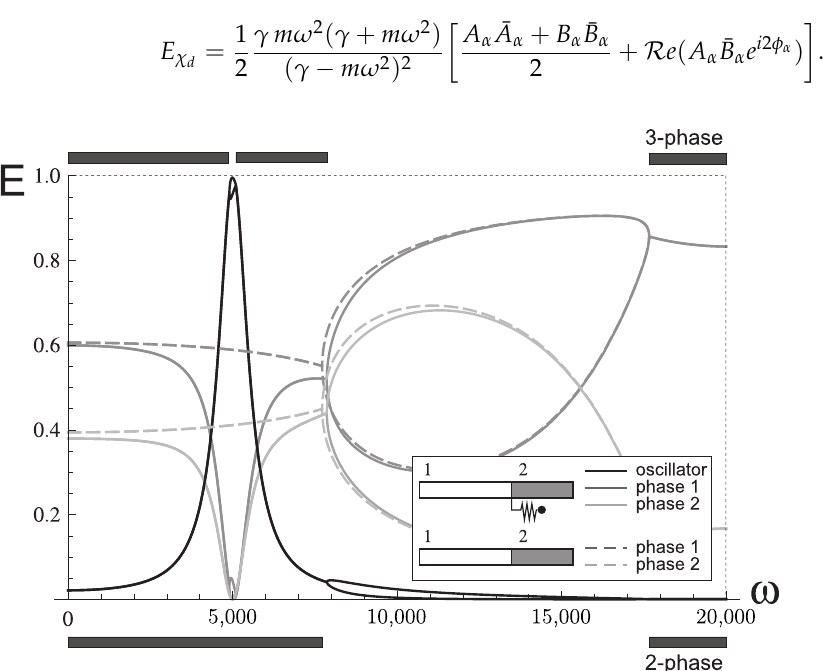
Figure 13. Energy distribution between different phases as a function of the radian frequency ω . Dashed lines correspond to the bi-layered system, while the continuous line corresponds to the bi- layered system with the oscillator disposed in parallel (indicated in black). Material and geometrical parameters are the same as Figure 6a,b. Pass band frequency intervals are indicated at the top and at the bottom of the